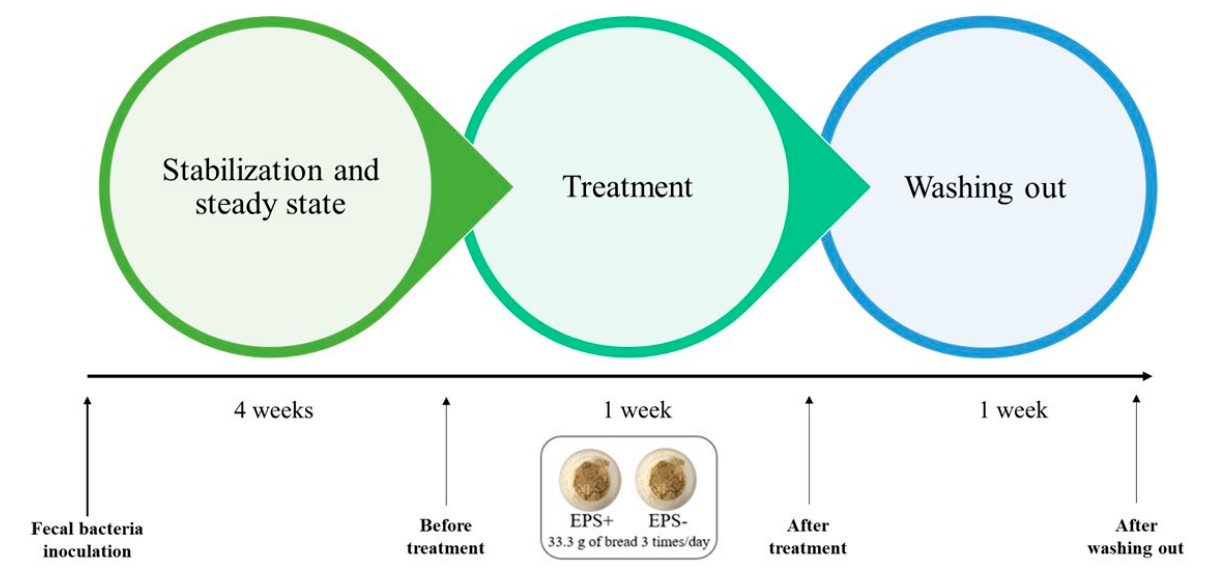
Figure 2. Experimental design of the Simulator of the Human Intestinal Microbial Ecosystem (SHIME ® ). Different running periods and sampling points are illustrated in the schematic diagram. After fecal inoculation, a stabilization (2 weeks) and a steady state (2 weeks) period were followed by one week of treatment period and one week of wash out period. During the treatment period, digested EPS+BB and EPS-BB breads were added to the SHIME ® feeding cycles (one for each